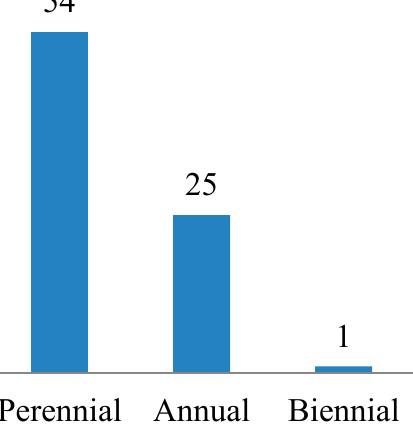
Figure 3. Number of species distributed across different families recorded in Wadi Hagul.